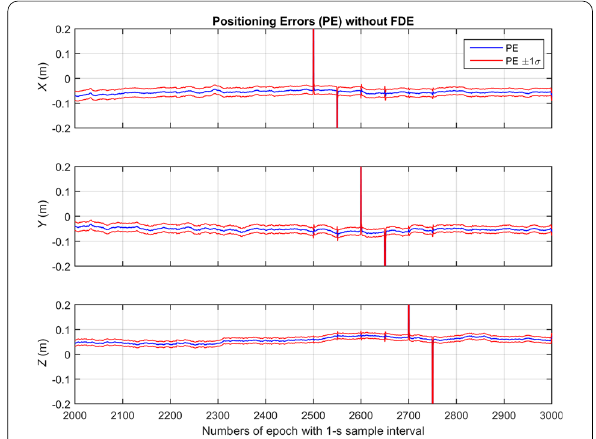
Fig. 7 PPP positioning errors (after convergence) in the case of faulty predicted states, with no FDE applied